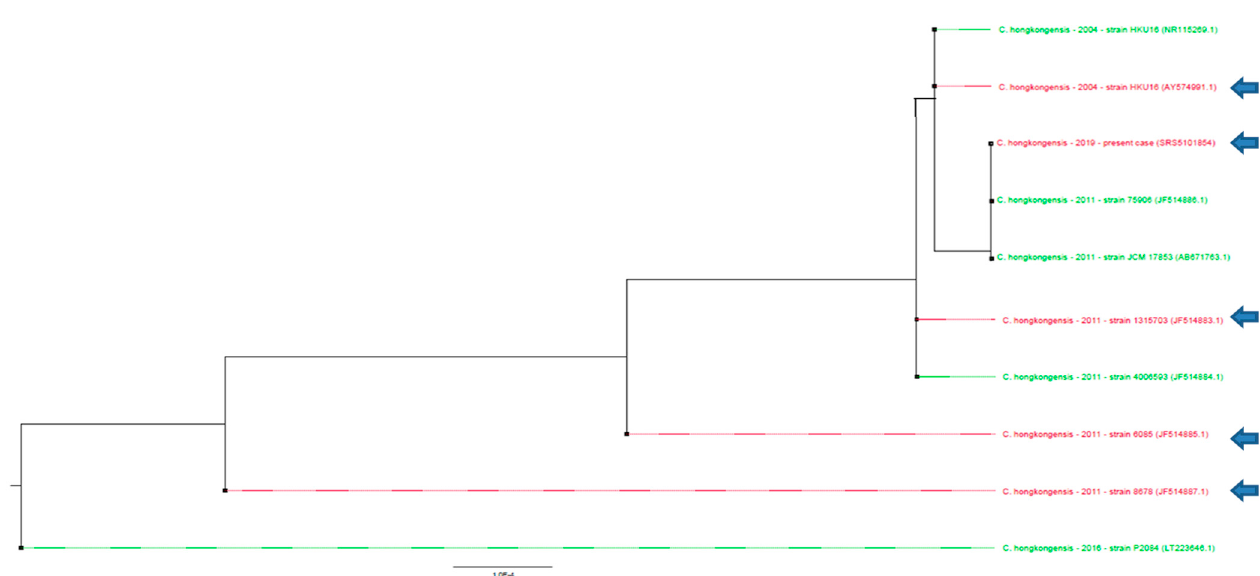
Figure 1. Phylogenetic analysis of Catabacter hongkongensis identified in blood cultures. Phylogenetic tree drawn up by ML-Method on 631 bases, on available sequences. An arrow indicates strains of Catabacter hongkongensis responsible for lethal infections. No significant association of these sequences could be obtained in terms of severity ( p > 0.05) as no clustering could be statistically observed. No significant clustering could be observed regarding the antibiotic sensitivity testing (AST) profile using 16S rDNA sequencing phylogenetic analysis ( p > 0.05).